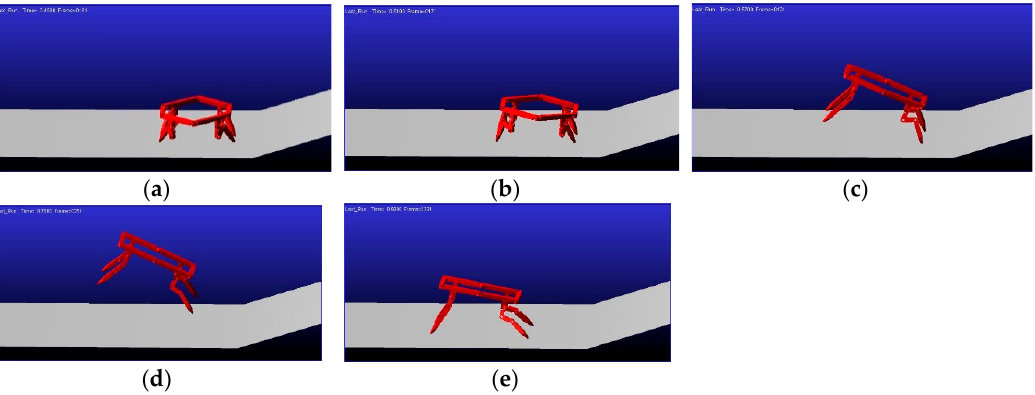
Figure 8. The simulation of jumping motion in Adams. ( a ) The Origaker II is in the initial posture; ( b ) The front legs kick the ground; ( c ) The hind legs and the trunk expand; ( d ) The robot jumps into the air; ( e ) The robot falls on the ground.